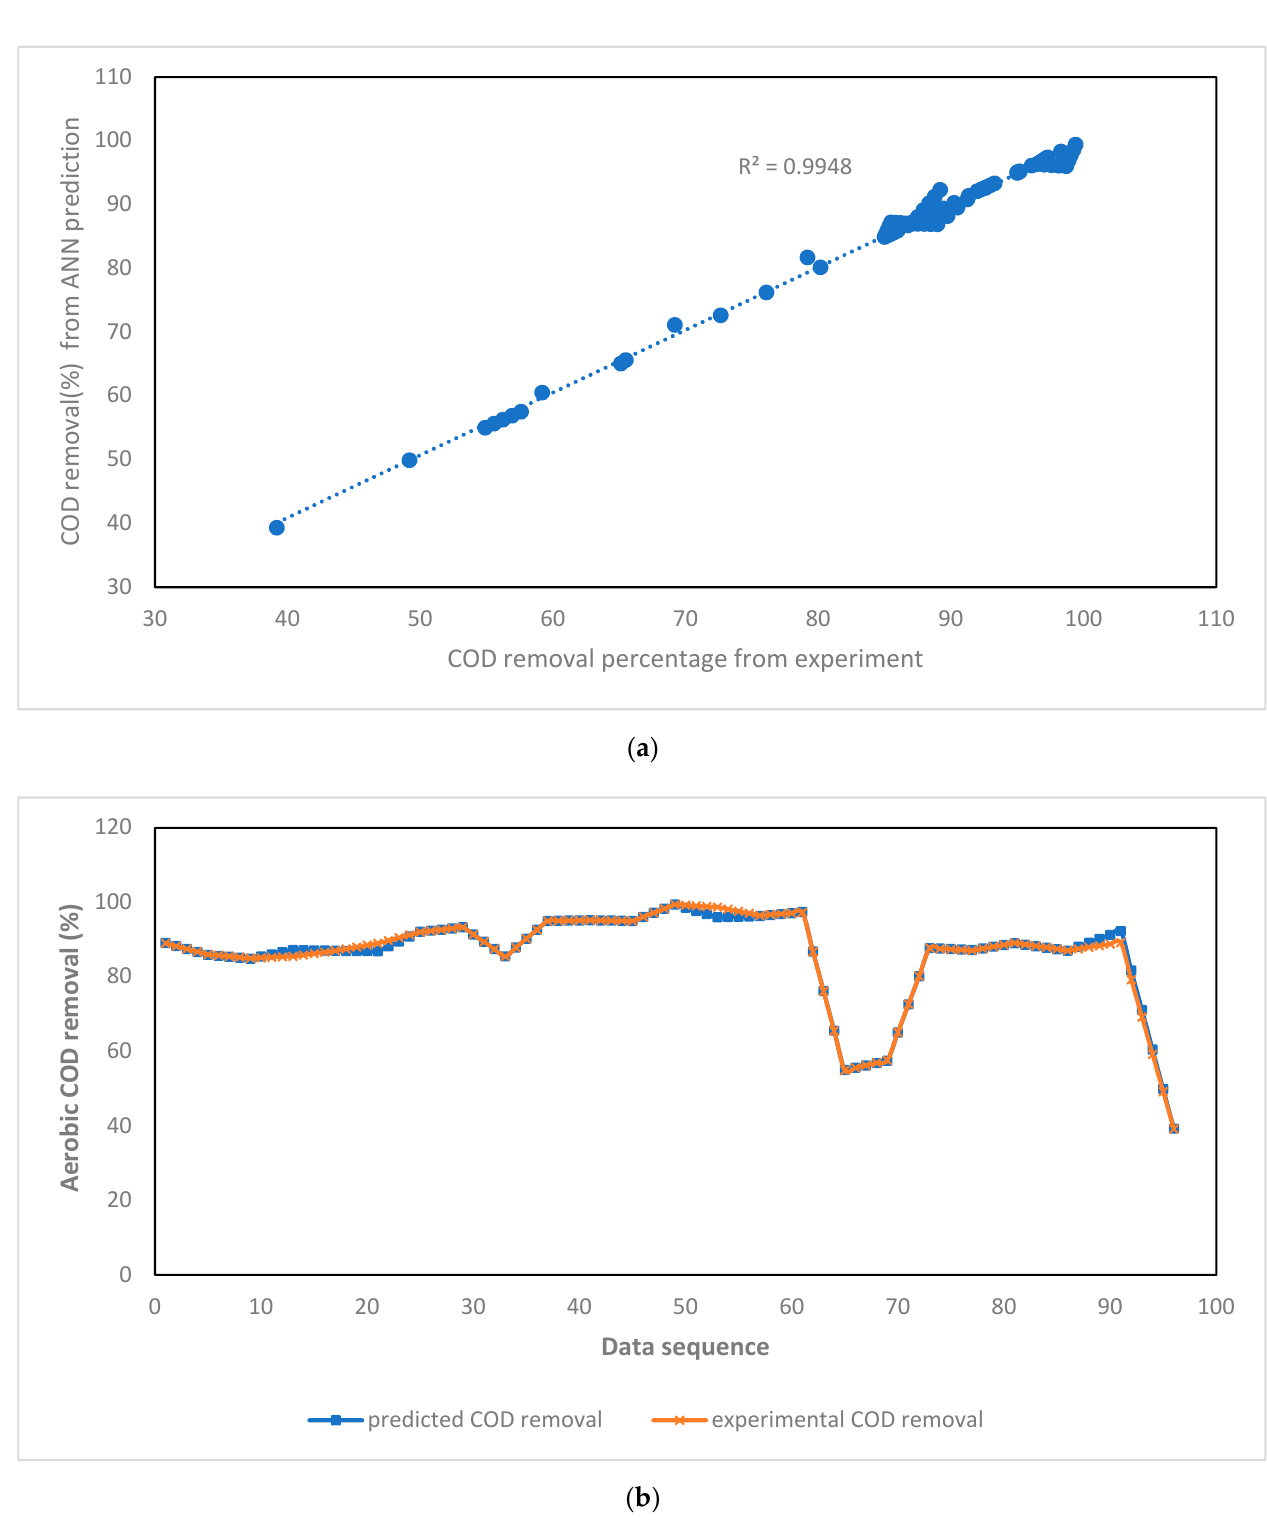
Figure 6. ( a ) Correlation between experimental data and predicted value of COD removal. ( b ) Prediction value and measured data by ANN model for COD removal (aerobic process). The high value of determination coefficient, R 2 value (Figure 7a) indicates that the ANN model is able to learn the non-linear relationship between the input and output parameters well. In Figure 7b, minimal deviation can be observed between the experimental BOD removal and predicted BOD removal values.